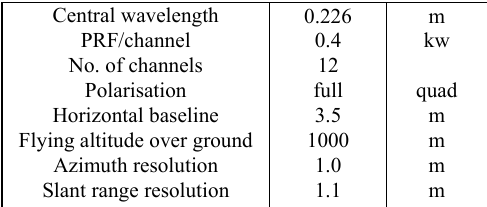
Figure 2b: Tomogram along Azimuth